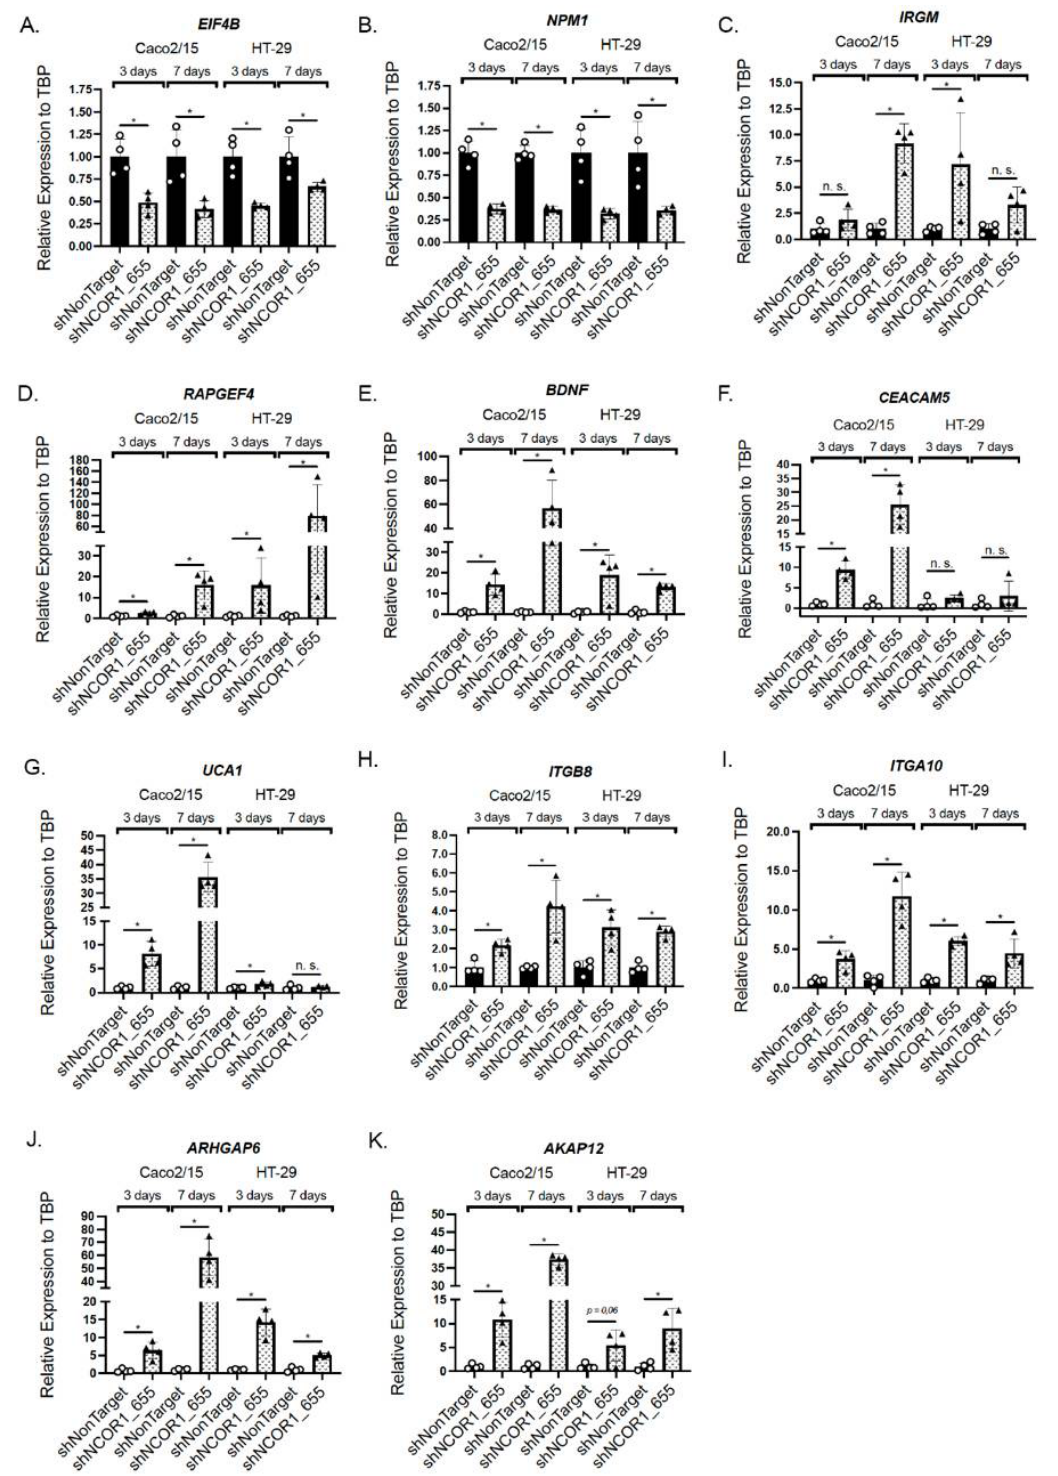
Figure 8. Confirmatory analysis of NCOR1 gene targets in CRC cells. Total RNA was isolated at 3 and 7 days following lentiviral infection of Caco-2/15 and HT-29 cells with shNonTarget or shNCOR1_655 constructs. EIF4B ( A ), NPM1 ( B ), IRGM ( C ), RAPGEF4 ( D ), BDNF ( E ), CEACAM5 ( F ), UCA1 ( G ), ITGB8 ( H ), ITGA10 ( I ), ARHGAP6 ( J ), and AKAP12 ( K ) expression values relative to TBP were measured by qRT-PCR ( n = 3–4; means ± SEM). Student’s t -tests were used to measure the significance of the results (* p <